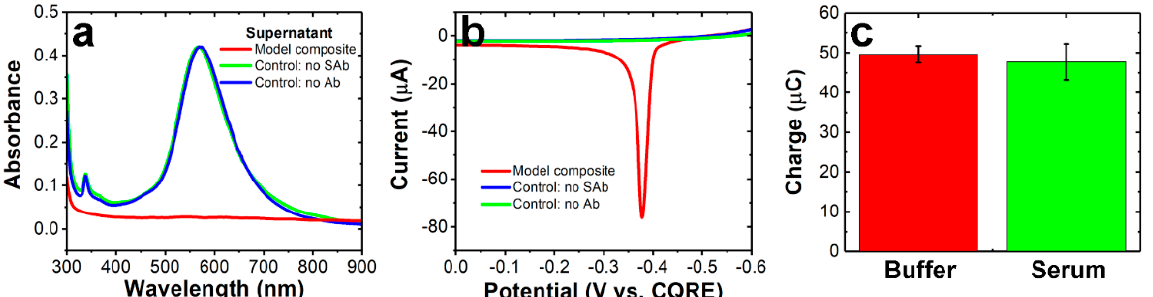
Figure 3. Demonstration of formation of the model composite using a AgND concentration of 25 pM. ( a ) UV-vis spectra of supernatants of solutions obtained after magnetic separation of the conjugate. The two control experiments are performed in the absence of SAbs on the MµBs or without Abs on AgNDs. All spectra were obtained in 1.0 mM sodium citrate solution using a 50.0 µL cuvette having a 1.00 cm pathlength. ( b ) Representative ASVs of the corresponding model composite were collected by magnetic separation. ( c ) Comparison of charges measured using the model assay formed in buffer and human serum. The error bars represent the standard deviation from the mean for three independent measurements.